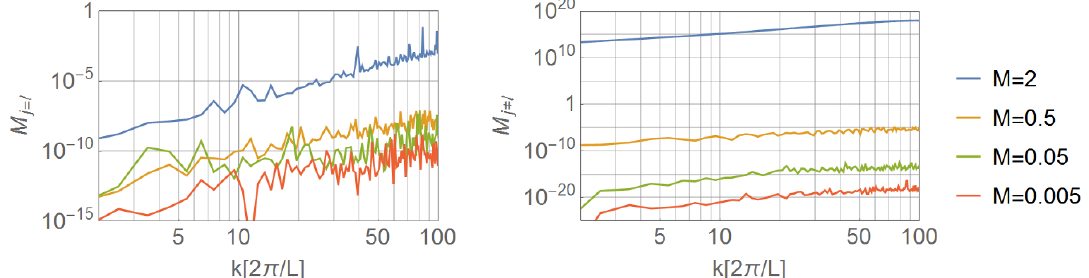
R dk p jF [ @ R dk p jF [ @ 2 and @ 2 denoted j ( @ ‘ a=a )] j j ( f ‘ =a )] j @k @k